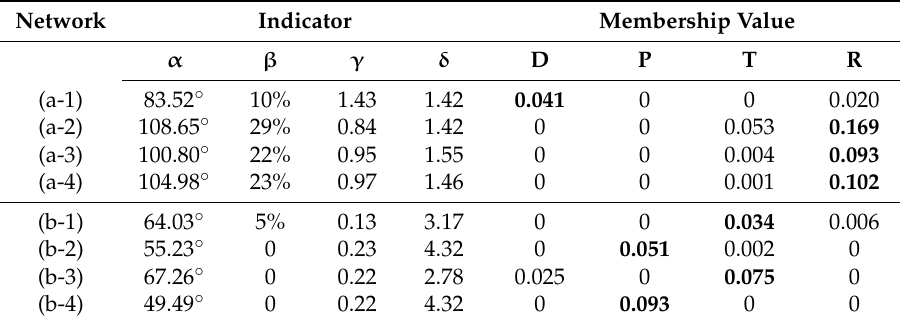
Table 12. Assessment for river networks in Figure